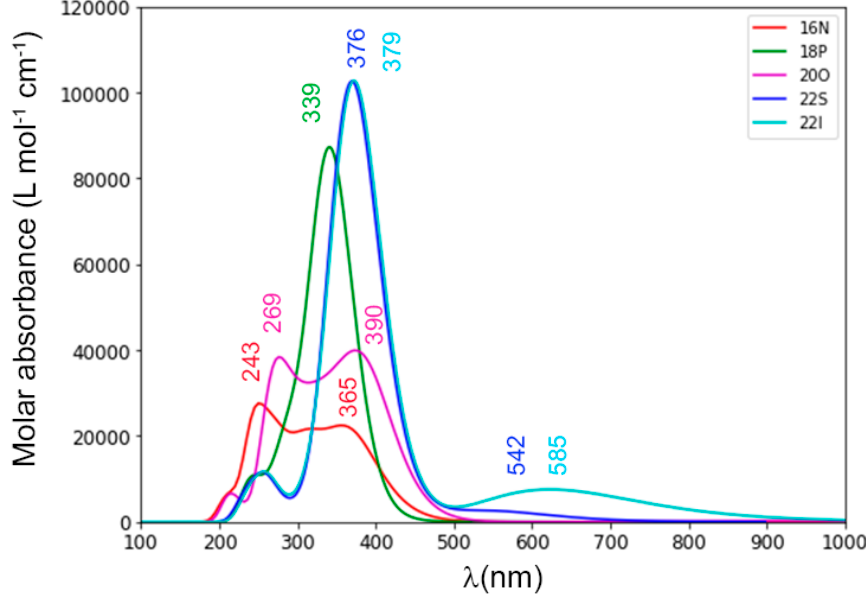
Figure 5. UV/vis absorption spectra of unsubstituted Hückel porphyrinoids simulated using Gaussian functions with a halfwidth of 2686 cm − 1 .